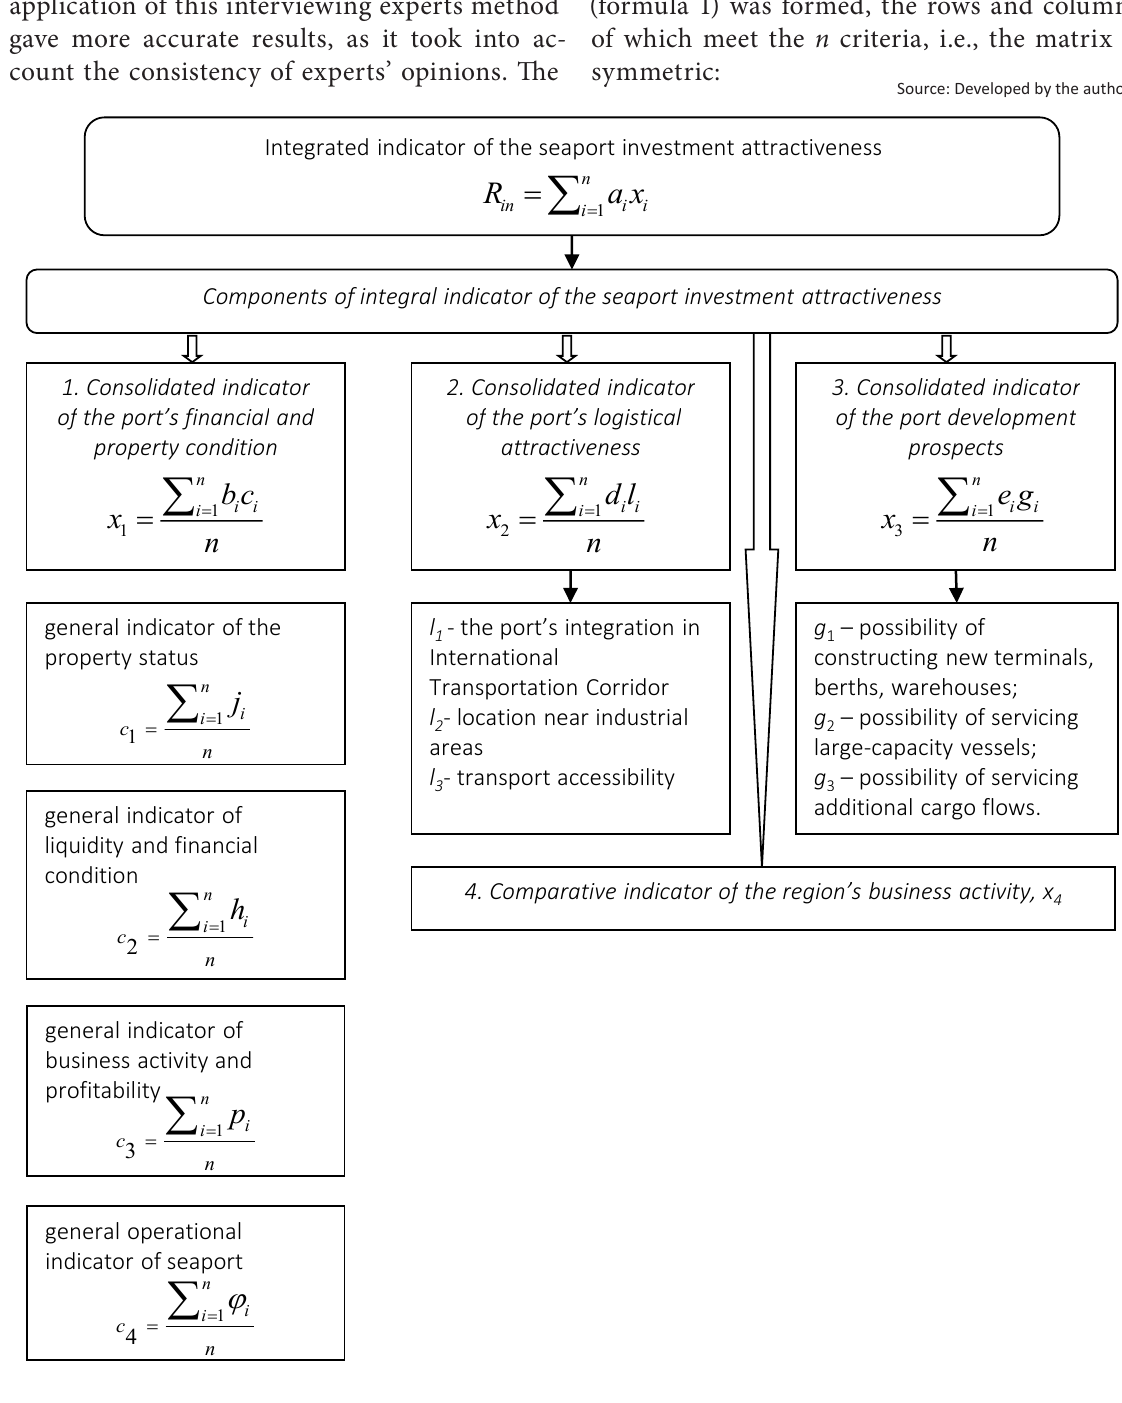
Figure 1. Structural and logical scheme for determining the integral indicator of the seaport investment